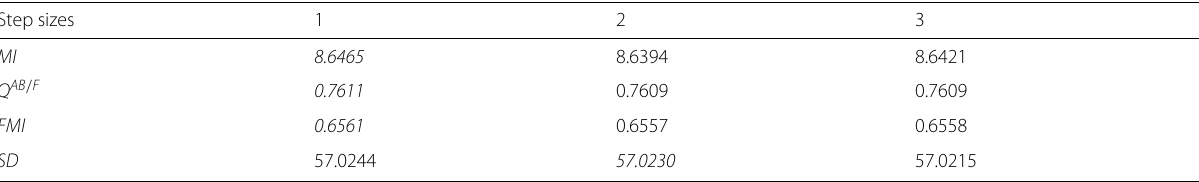
Table 4 Quantitative comparisons with regard to different steps Step